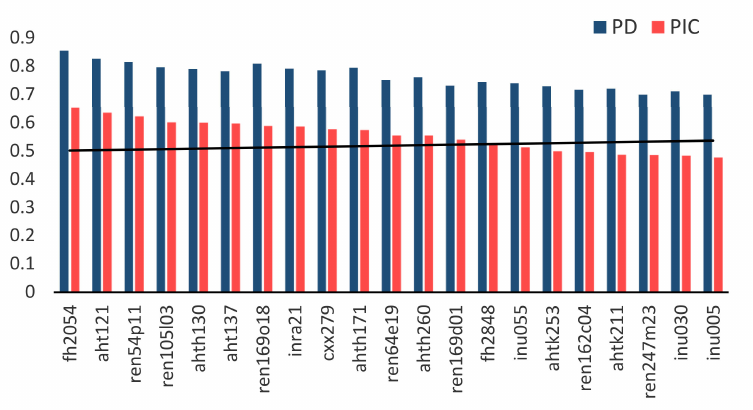
Figure 3. Mean values of the polymorphic information content (PIC) and power of discrimination (PD) for the eight dog breeds under